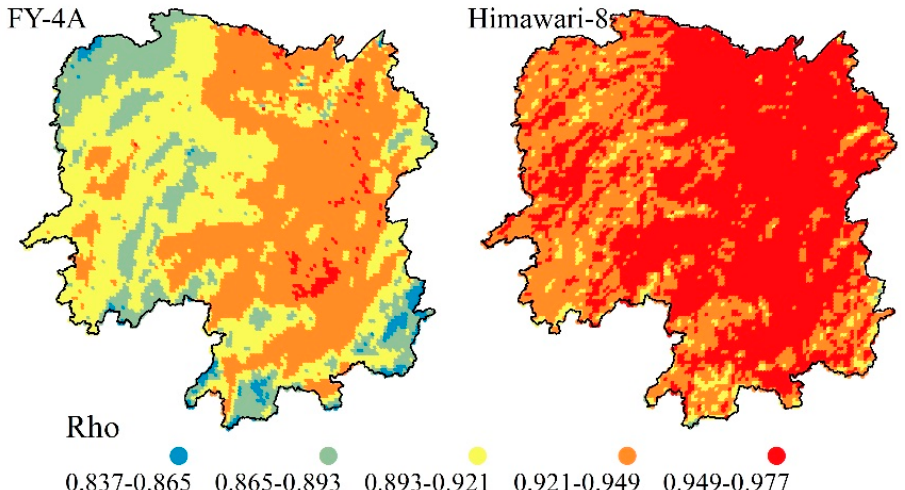
Figure 4. Spatial distribution of Rho from TCA of FY-4A (left) and Himawari-8 (right) LSTs in Hunan Province; results are only shown for grids in which all three datasets showed a significant positive correlation and there were >100 data triplets.